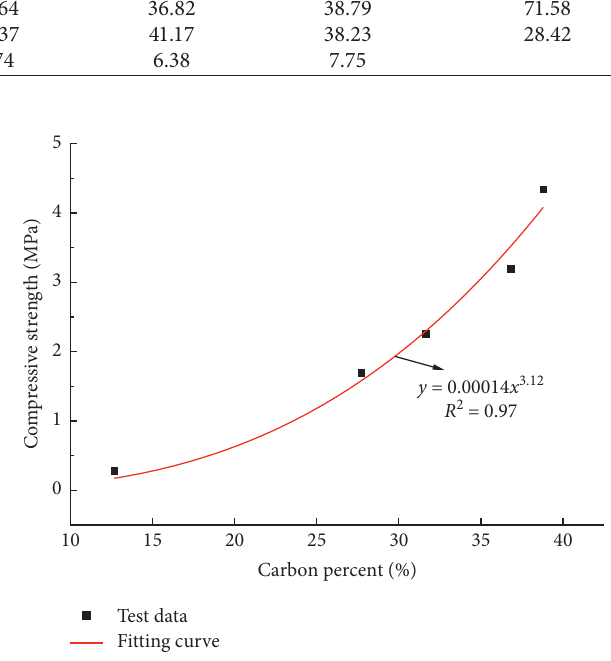
Figure 12: Relationship between carbon content and compressive